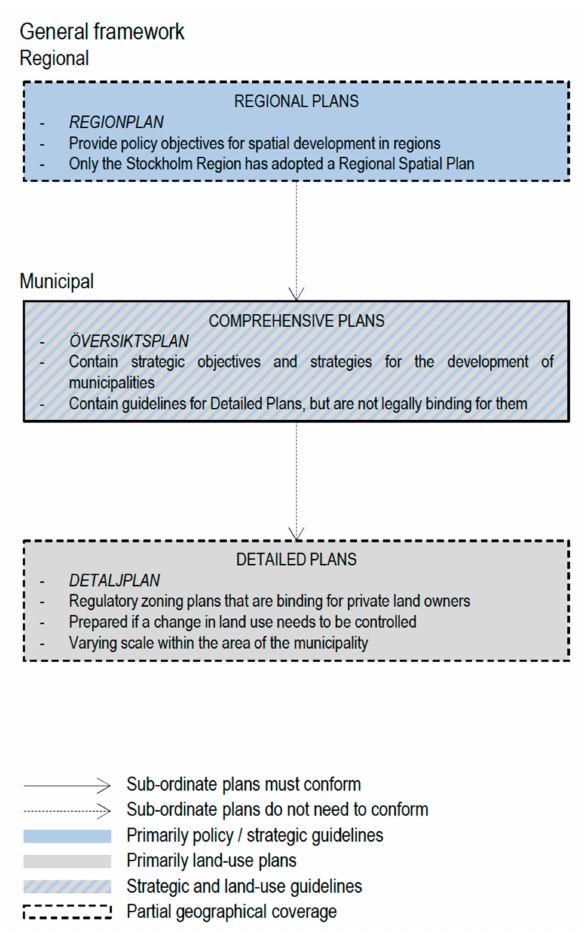
Figure 11. Organisation of spatial and land-use planning in Sweden